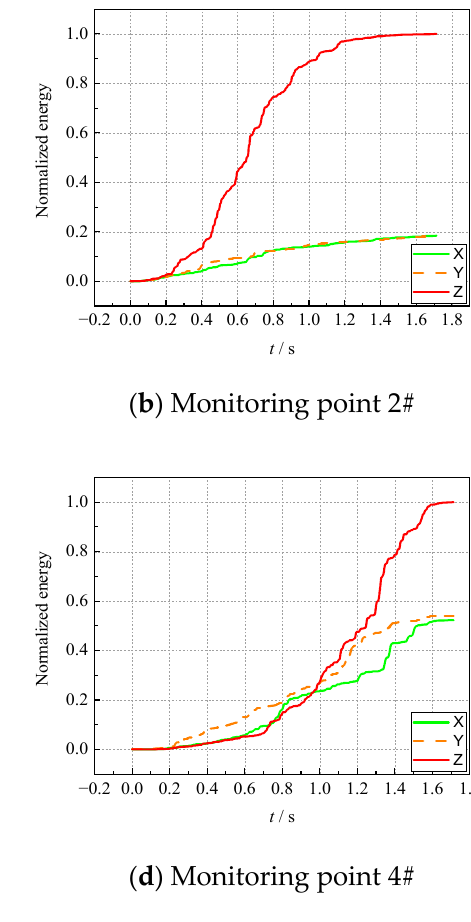
Figure 12. Cumulative energy curve.